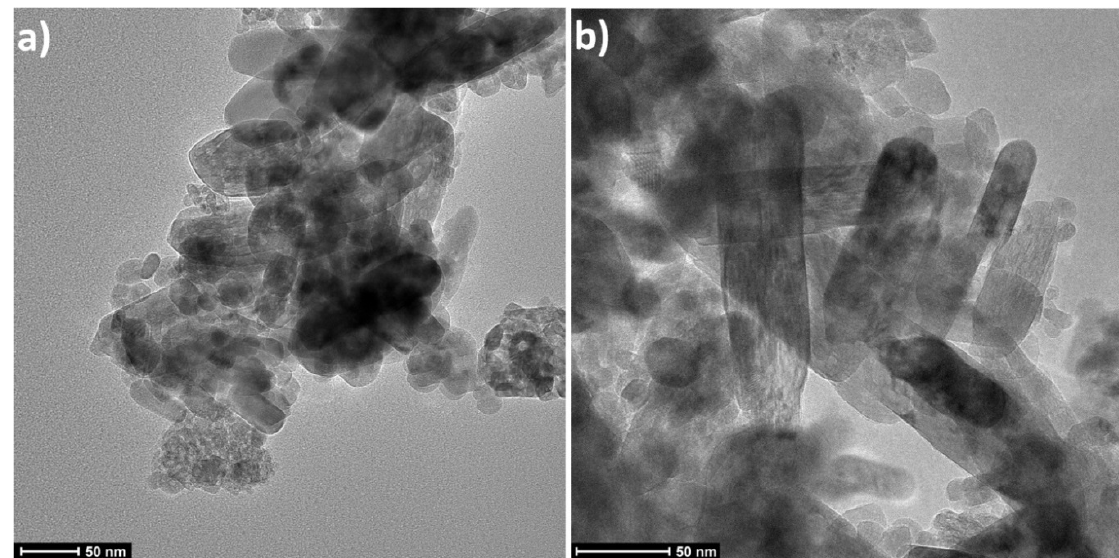
Figure 3. TEM images of NPs: ( a , b ) TiO 2 .